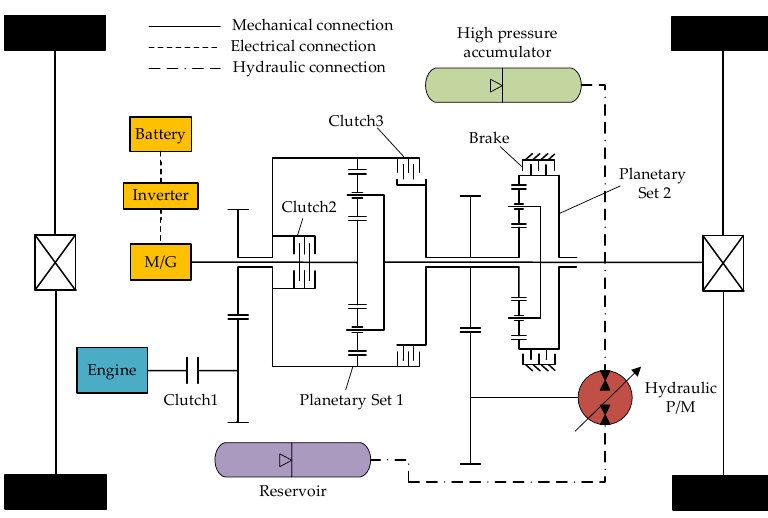
Figure 2. The specific structure of a hydraulic/electric synergy vehicle. Table 1. Working pattern division. M/G: motor/generator; P/M: pump/motor.